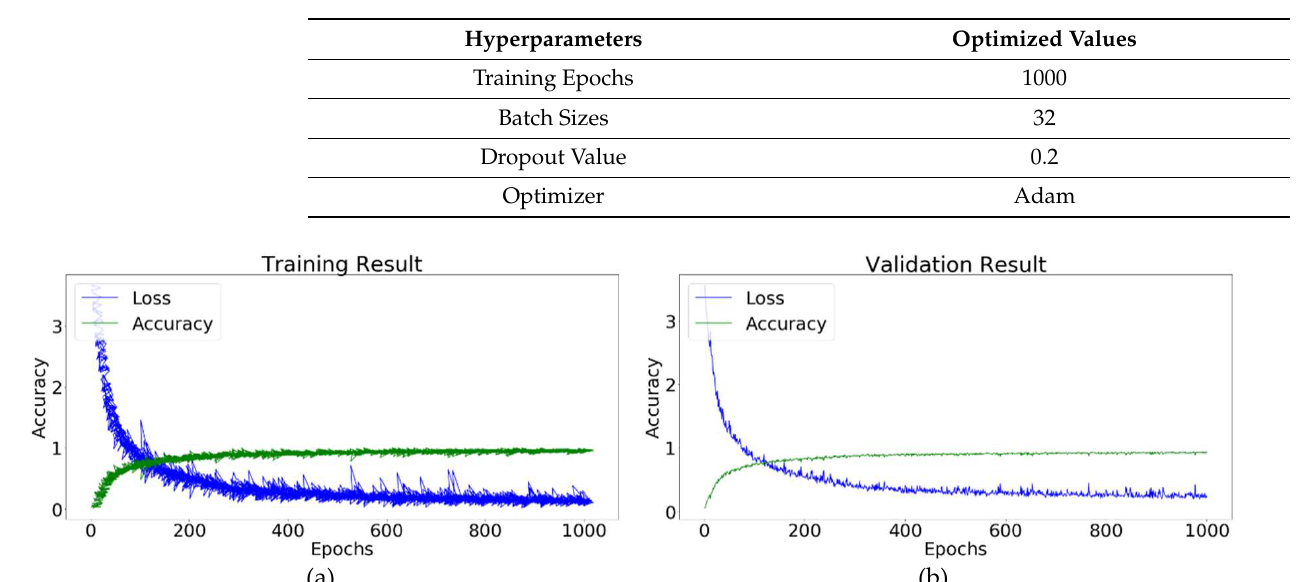
Figure 15. Conv-5 DCNN model: ( a ) Training result; ( b ) validation result.